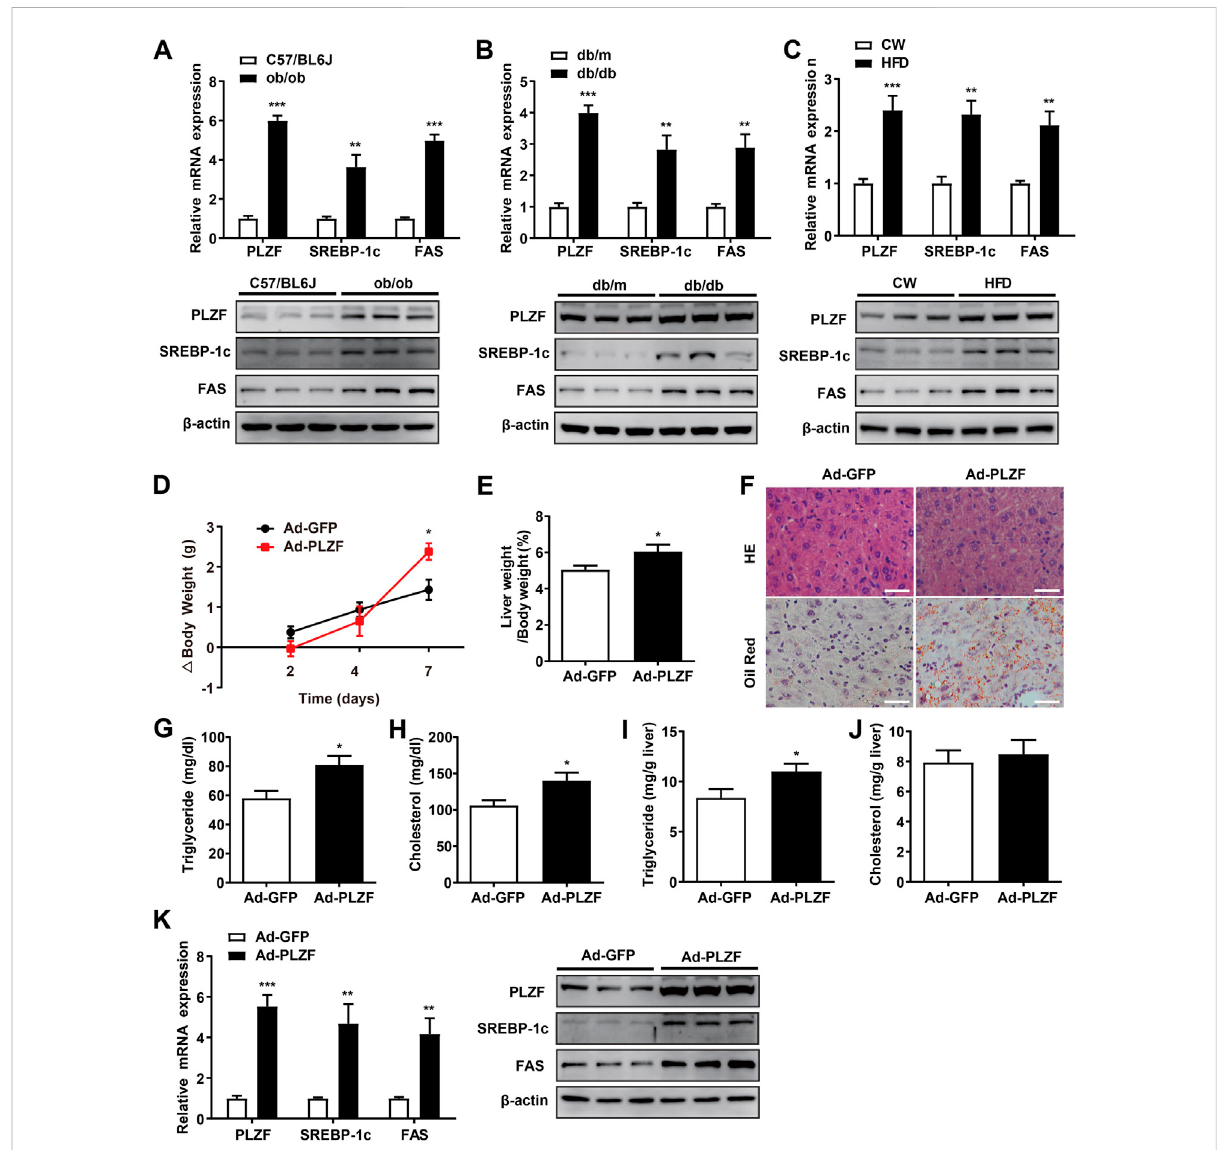
FIGURE 1 Hepatic PLZF gene expression is upregulated in NAFLD mice and adenovirus-mediated PLZF overexpression in C57BL/6J mouse livers leads to improvement in the fatty liver phenotype. PLZF, SREBP-1c, and Fas expression is presented in qPCR analysis (top panel) and western blot analysis (bottom panel). (A) C57BL/6J control mice and ob/ob mice, (B) db/m control mice and db/db mice, and (C) C57BL/6J mice that were fed a normal chow or a high-fat diet for 16 weeks (DIO mice). Ad-GFP or Ad-PLZF adenovirus was injected into C57BL/6J mice (male). Mice were sacri fi ced for further analysis. Depicted are (D) body weight change, (E) liver weight to body weight ratio, (F) representative section staining of livers with H&E (top panel) and Oil Red O (bottom panel), (G) serum TG, (H) serum cholesterol, (I) hepatic TG, (J) hepatic cholesterol. SREBP-1c and Fas in livers of mice treated with the indicated adenovirus were analyzed with (K) qPCR analysis (left panel) and western blot analysis (right panel). N = 6 – 8/ group. For adenovirus injection, mice were injected via their tail vein with adenovirus. Then, 5 – 7 days after infection, mice livers and plasma were collected for further analysis. The data shown are the means ± SEM. Scale bar, 50 μ m * p < 0.05, ** p < 0.01, *** p <